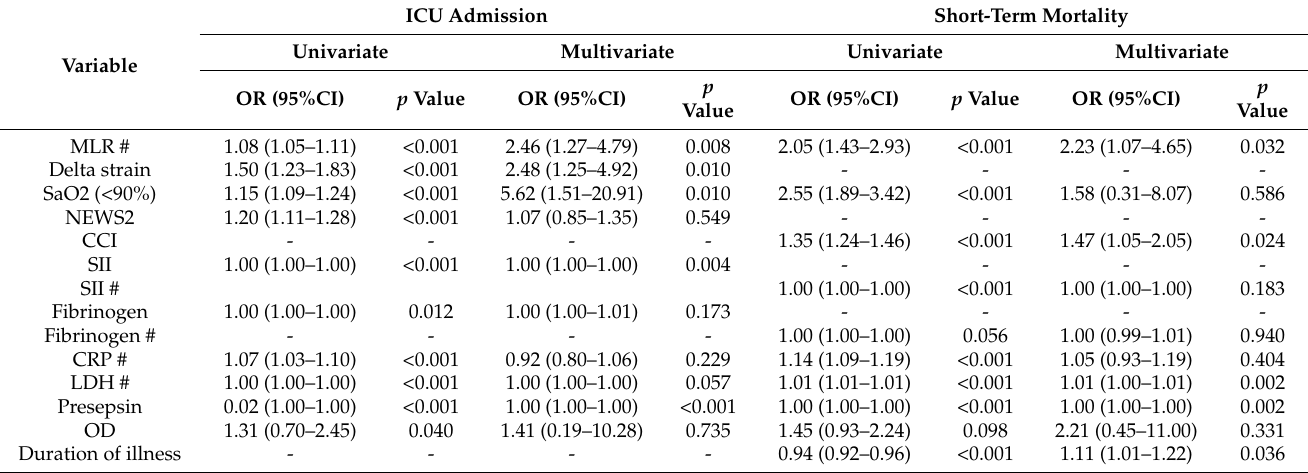
Table 3. Logistic regression models for the main outcomes’ prediction including follow-up